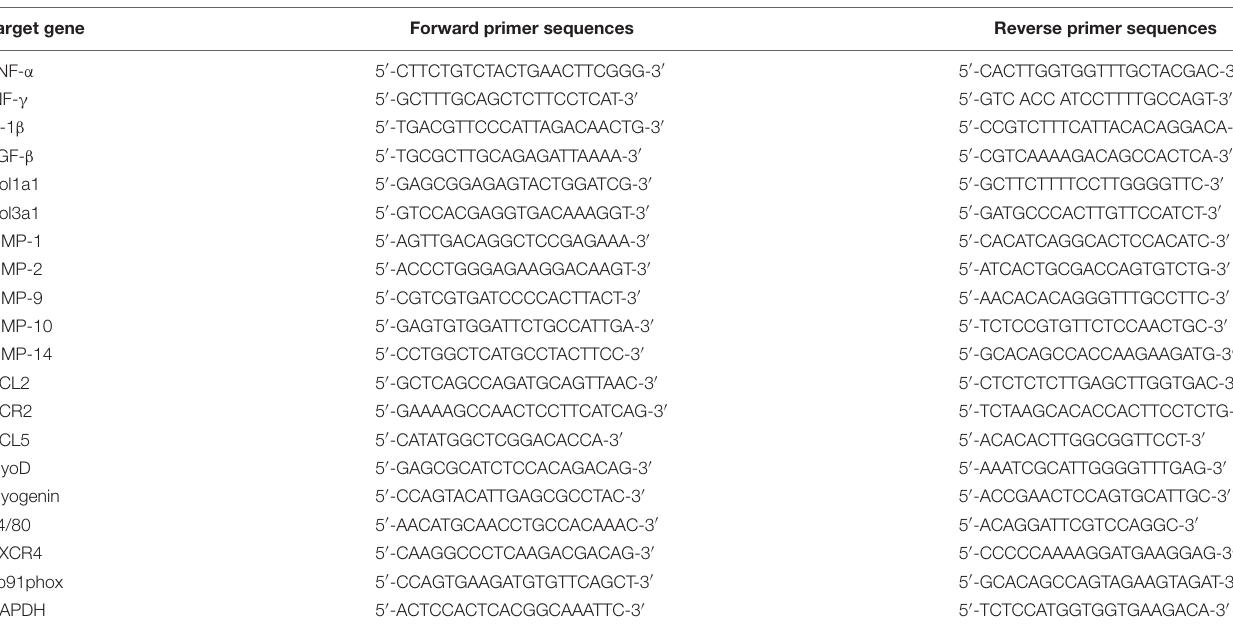
TABLE 1 | Primers used for